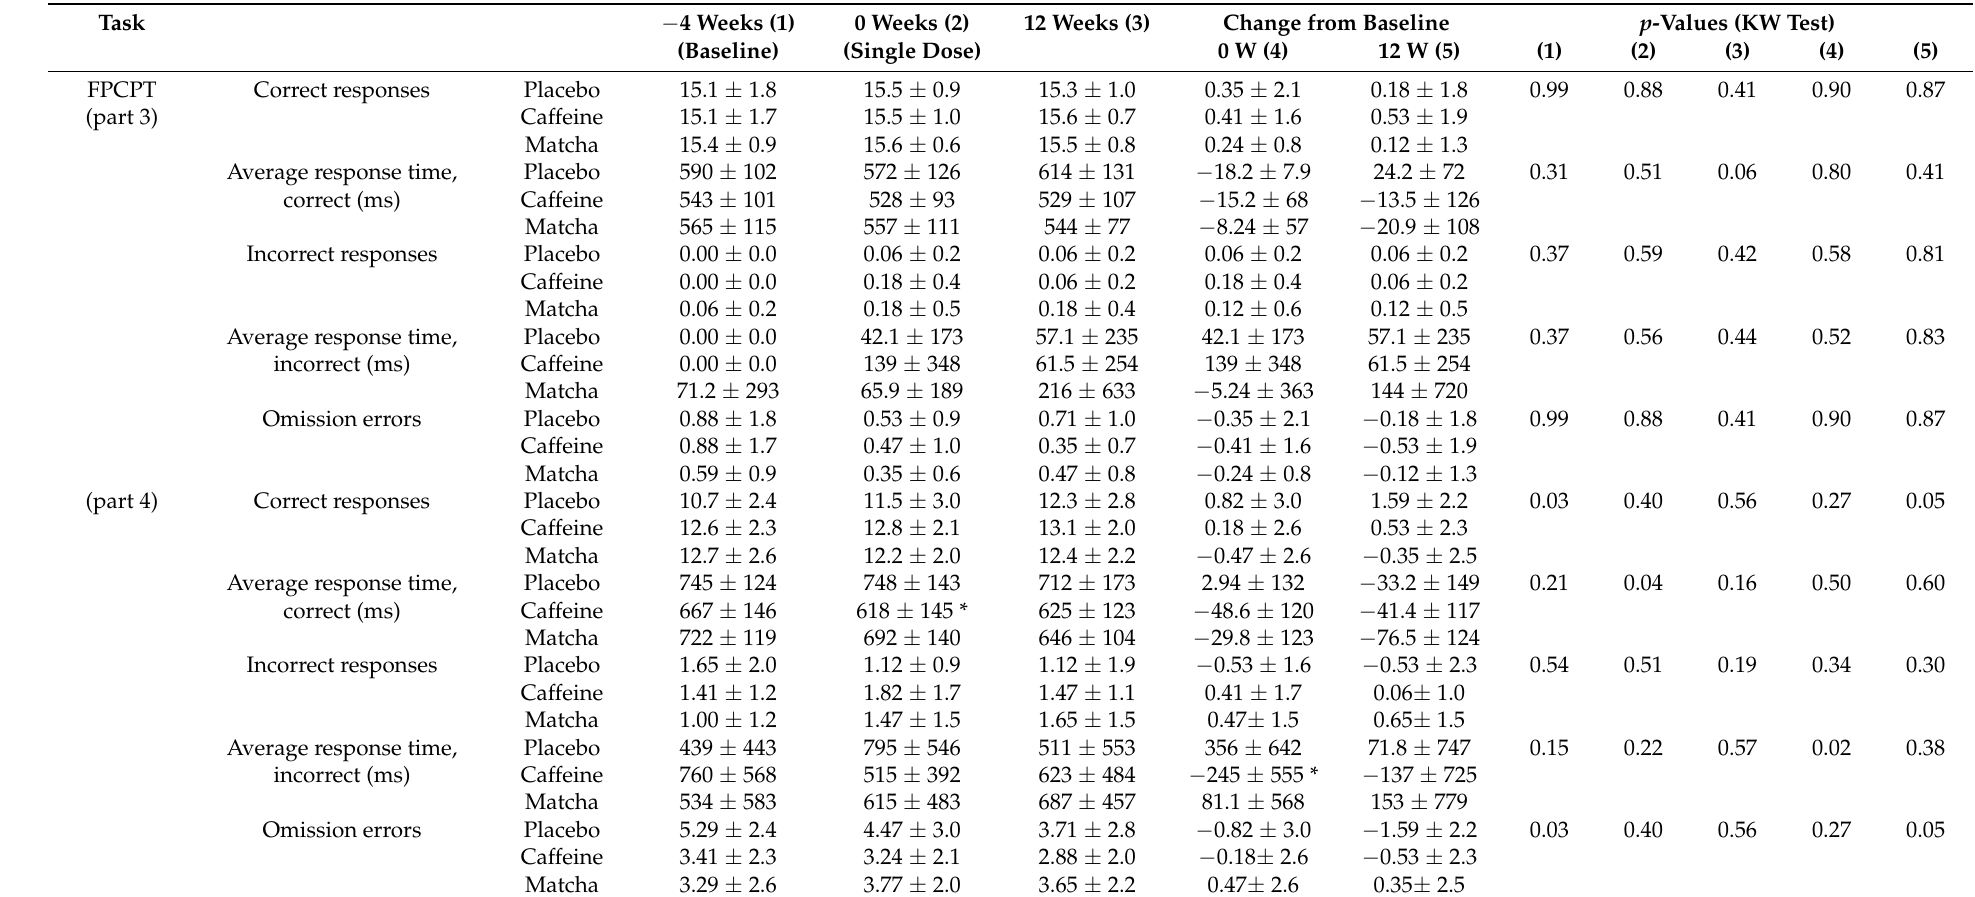
Table 7. Effect of matcha or caffeine intake on working memory-related